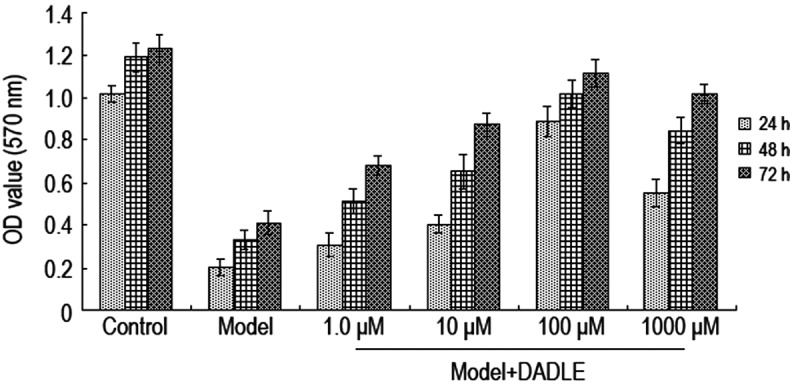
DADLE reverses the I/R-induced growth inhibition of intestinal epithelial cells. Following treatment with different concentrations of DADLE (1, 10, 100 or 1,000 µM) for 24, 48 and 72 h, the viability of the intestinal epithelial cells was determined using an MTT assay. Each independent experimental group was repeated in triplicate. Data are presented as the mean ± standard deviation. *P<0.05. DADLE, (D-Ala2, D-Leu5)-enkephalin; OD, optical density; Model, ischemia/reperfusion.